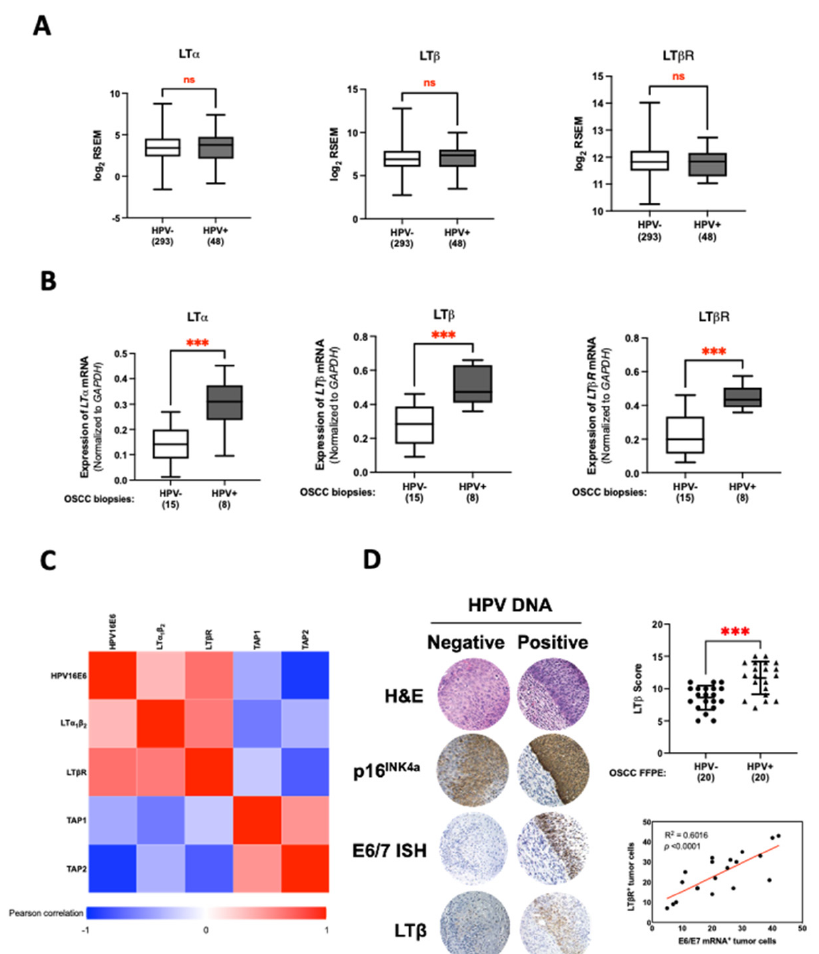
Figure 4. Involvement of the LT network in suppression of TAP1 and TAP2 in HPV-infected OSCCs. ( A ) The expression of LT-related genes (LT α , LT β and LT β R) in HPV-positive and HPV-negative OSCC tissues. ( B ) The expression of LT α , LT β , and LT β R mRNA in OSCC biopsy samples with HPV infection and non-HPV infection assessed by qRT-PCR. ( C ) Pearson correlation of mRNA expressions among LT-related genes (LT α , LT β , and LT β R), HPV16E6, and TAP genes (TAP1 and TAP2) in OSCC tissues. Genes are shown on the horizontal and vertical axes. Red cells represent a positive correlation, and blue cells a negative correlation. The color bar indicates the r-value. ( D ) Serial sections of HPV DNA-negative and HPV DNA-positive OSCC tissues were stained with H&E, E6/E7 mRNA ISH, and antibodies targeting p16 INK4a , and LT β . All images were originally taken using a 20× objective lens, magnification: 400×. IHC scores of the indicated genes in 20 HPV-positive and 20 HPV-negative OSCC FFPE samples (right-upper). Pearson correlation was calculated for LT β R and HPV16 E6 (right-lower). All experiments were carried out in triplicate, and at least three independent experiments were performed. *** p ≤ 0.001; ns—not significant.